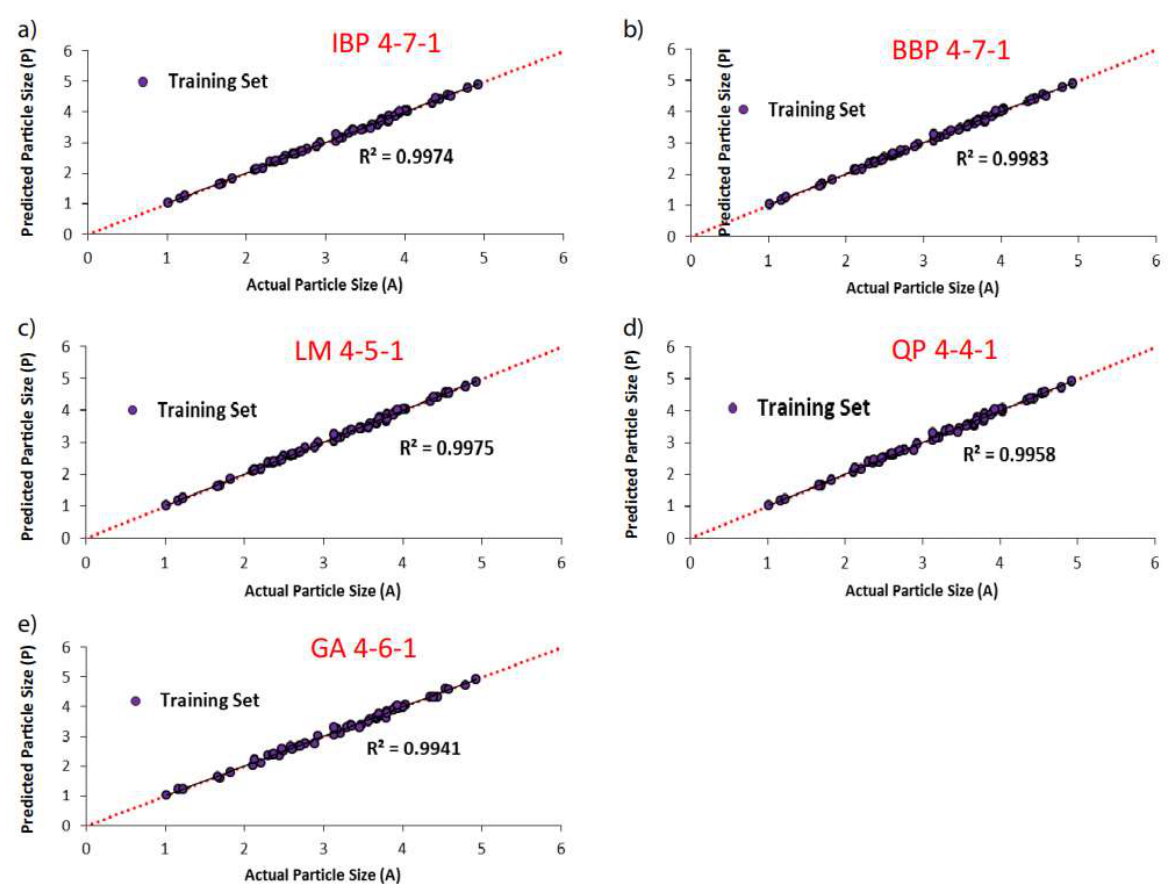
Figure 4. Scatter plots of the predicted Dp (in nm) against an actual range of Dp for the training set of data for the selected topologies with Soroush SOLTANI [38]. The designated topologies were 4-7-1, 4-7-1, 4-5-1, 4-4-3, and 4-6-1 for ( a ) IBP; ( b ) BBP; ( c ) LM; ( d ) QP; ( e ) GA algorithms, respectively Reprinted (adapted) with permission. Copyright 2020.